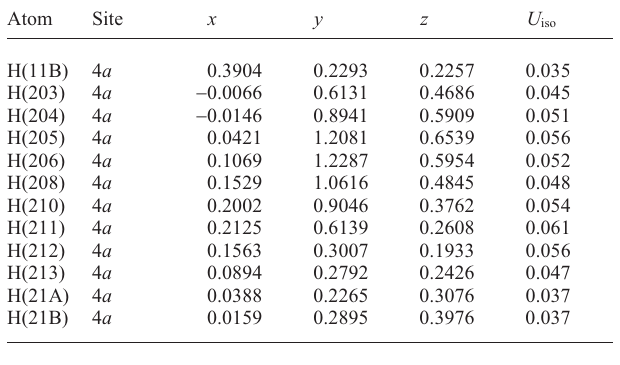
Table 2. Atomic coordinates and displacement parameters (in Å 2 ) .